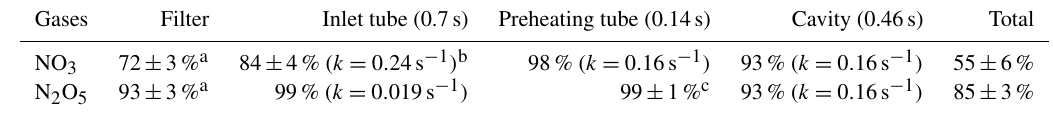
Table 1. The transmission efficiency of NO 3 and N 2 O 5 for the sample module setup for the developed instrument. Gases Filter Inlet tube (0.7s) Preheating tube (0.14s) Cavity (0.46s)